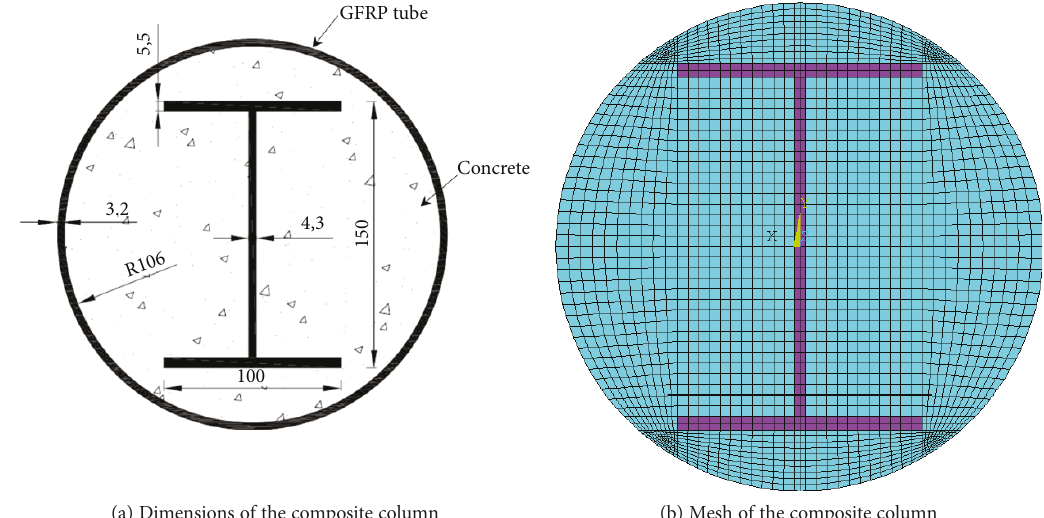
Figure 7: Dimensions and mesh of the composite column tested by Karimi et al. [15].